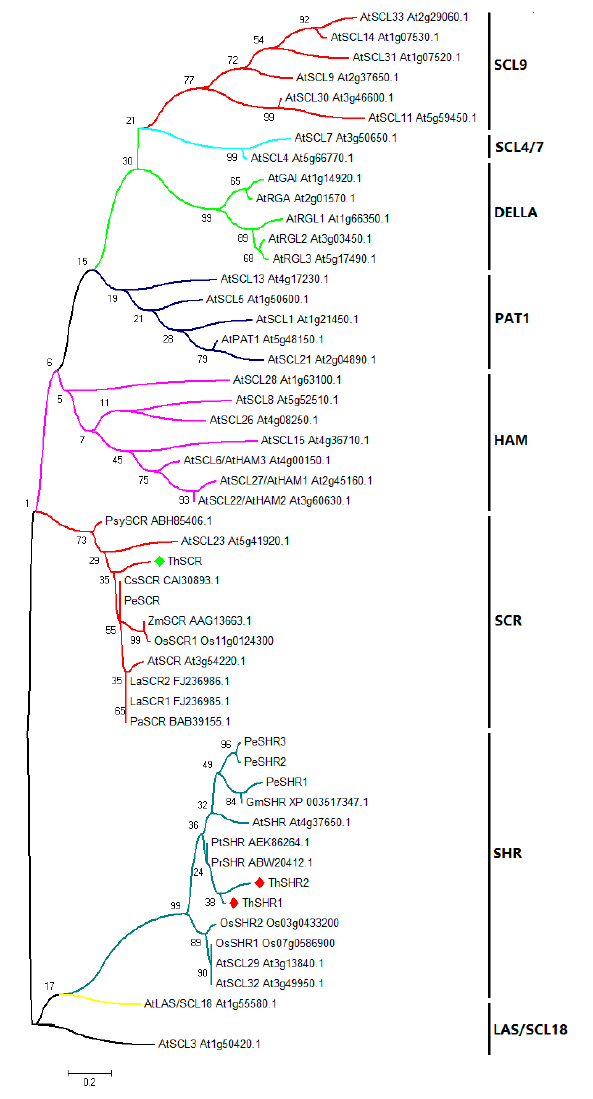
Figure 4. Phylogenetic analysis of the proteins of the GRAS gene family. The phylogenetic tree was constructed using MEGA 5.0 with the maximum likelihood method using 1000 replicate bootstrap tests. Numbers near to the nodes indicate bootstrap values obtained from 1000 replications. The 51 proteins were clustered into eight distinct groups: SCL9, PAT1, LAS/SCL18, SCL4/7, SHR, SCR, HAM and DELLA, as indicated. At, Arabidopsis thaliana ; Os, Oryza sativa ; Gm, Glycine max ; Pe, Populus ; Pr, Pinus radiata ; Pt, Pinus taeda ; La, Lupinus albus ; Ps, Pisum sativum ; Cs, Cucumis sativa ; Zm, Zea mays ; Psy, Pinus sylvestris .